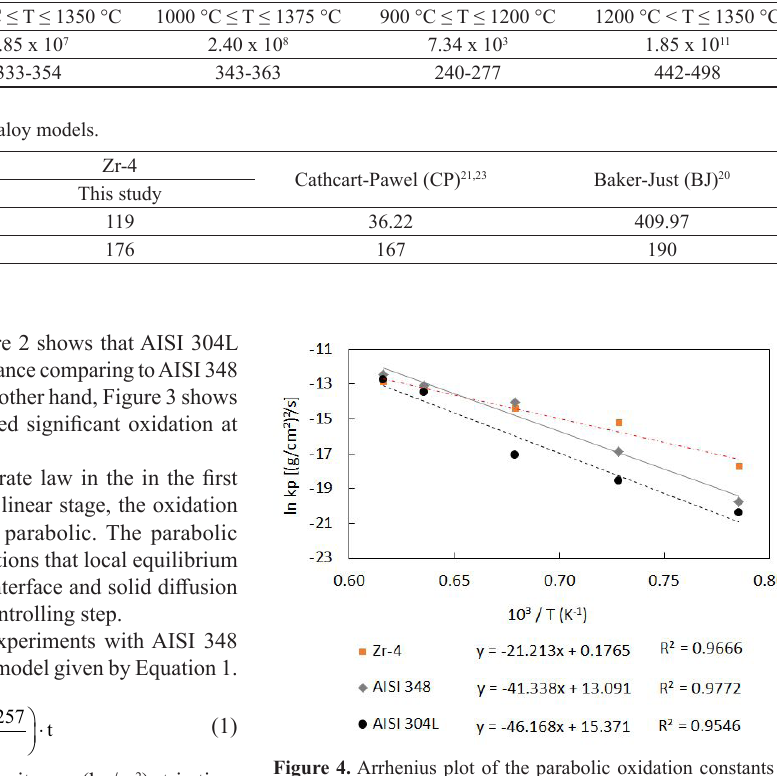
Figure 4. Arrhenius plot of the parabolic oxidation constants of AISI 304L, AISI 348, and Zircaloy-4 in water, where R 2 is the coefficient of determination of each linear regression.